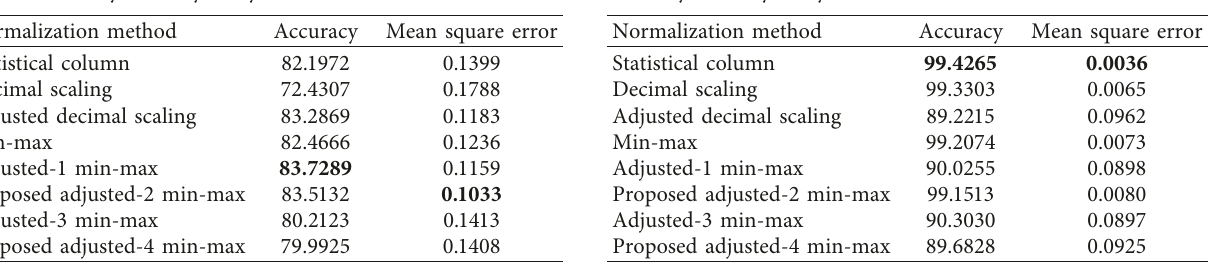
Table 8: Comparative results of prediction efficiency on avocado dataset yielded by every tested normalization method.